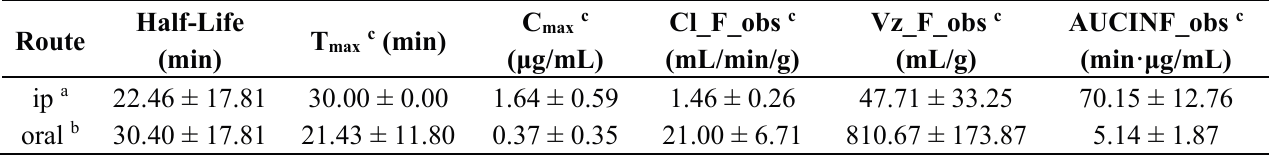
Table 1. Summary of pharmacokinetic (PK) parameters by route and schedule.